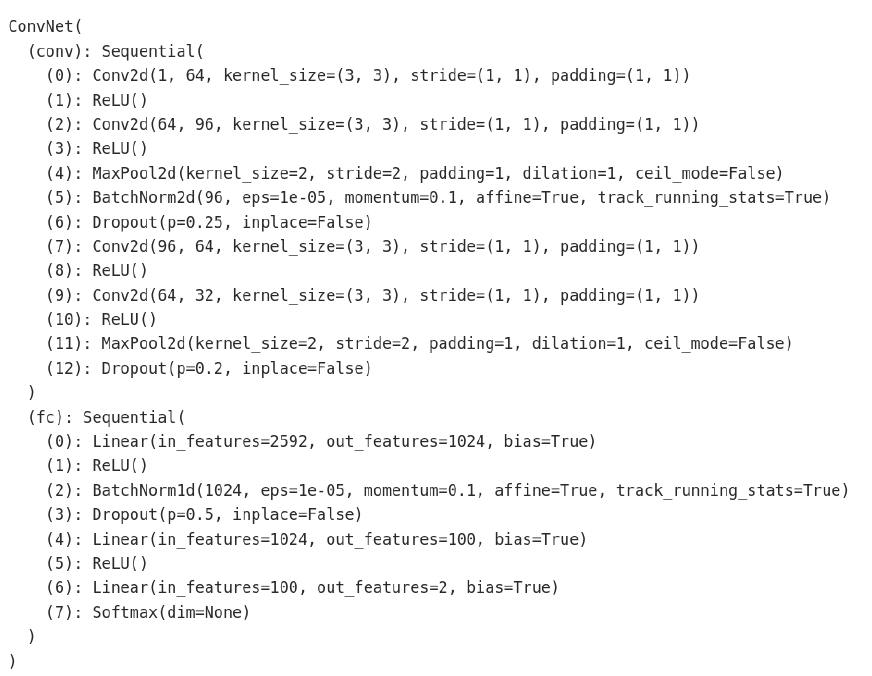
Figure 2. Our custom model architecture built as a Sequential Model which stacks series of feature extractors (2D-Convolutional Neural Networks), Activation function (ReLU), Down sampling opera- tor (MaxPooling), BatchNormalization and Regularizer (Dropout), Classifier (Fully connected layer) that uses SoftMax